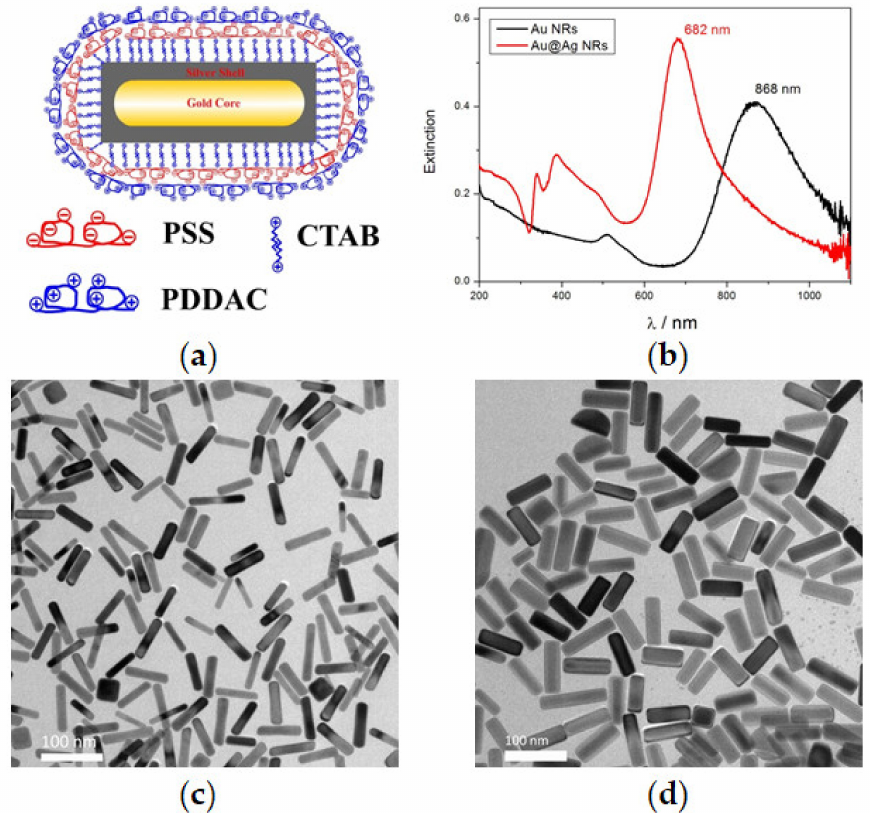
Figure 1. Physicochemical characterization of AuNRs and Au@Ag NRs used in animal experiments. ( a ) Schematic illustration of Au@Ag NRs. ( b ) UV-Vis spectrum. ( c , d ) Representative TEM images of AuNRs ( c ) and Au@Ag NRs ( d ),